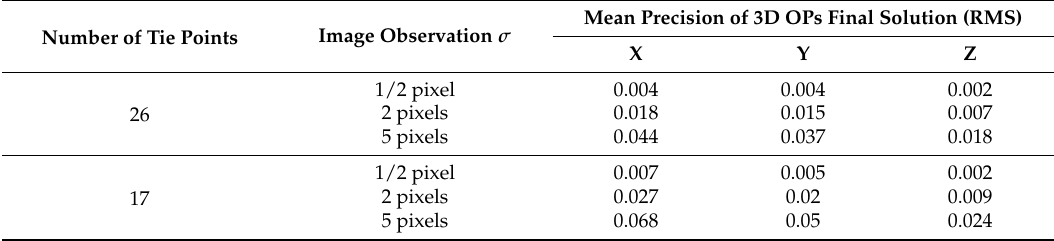
Table 6. The effect of changing observation weight on 3D OPs final solution RMS.